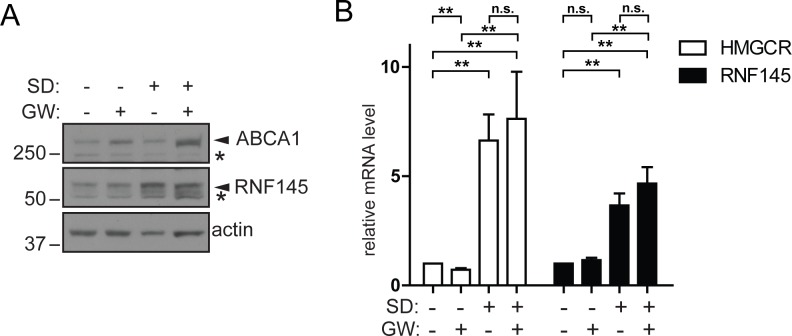
Increased RNF145 transcription upon sterol depletion is LXR-independent.(A) Hela cells were sterol-depleted (SD, 10% LPDS + 10 µM mevastatin + 50 µM mevalonate) for 48 hr in the presence of the synthetic LXR ligand GW3965 (GW, 1 µM) or DMSO (vehicle control). Whole–cell lysates were analysed by SDS-PAGE and immunoblot assay. Representative of ≥3 independent experiments. (B) HeLa Cells were treated as described in (A) and the expression of indicated genes determined by quantitative PCR. All values were normalised to the steady-state, DMSO treated condition (bars 1 and 5). Mean ± S.D. (n = 3) and significance are indicated, unpaired Students t-test: **p≤0.01, ***p≤0.001, n.s. not significant.10.7554/eLife.40009.018Figure 5—figure supplement 2—source data 1.Raw data from qPCR experiment in Figure 5—figure supplement 2B.